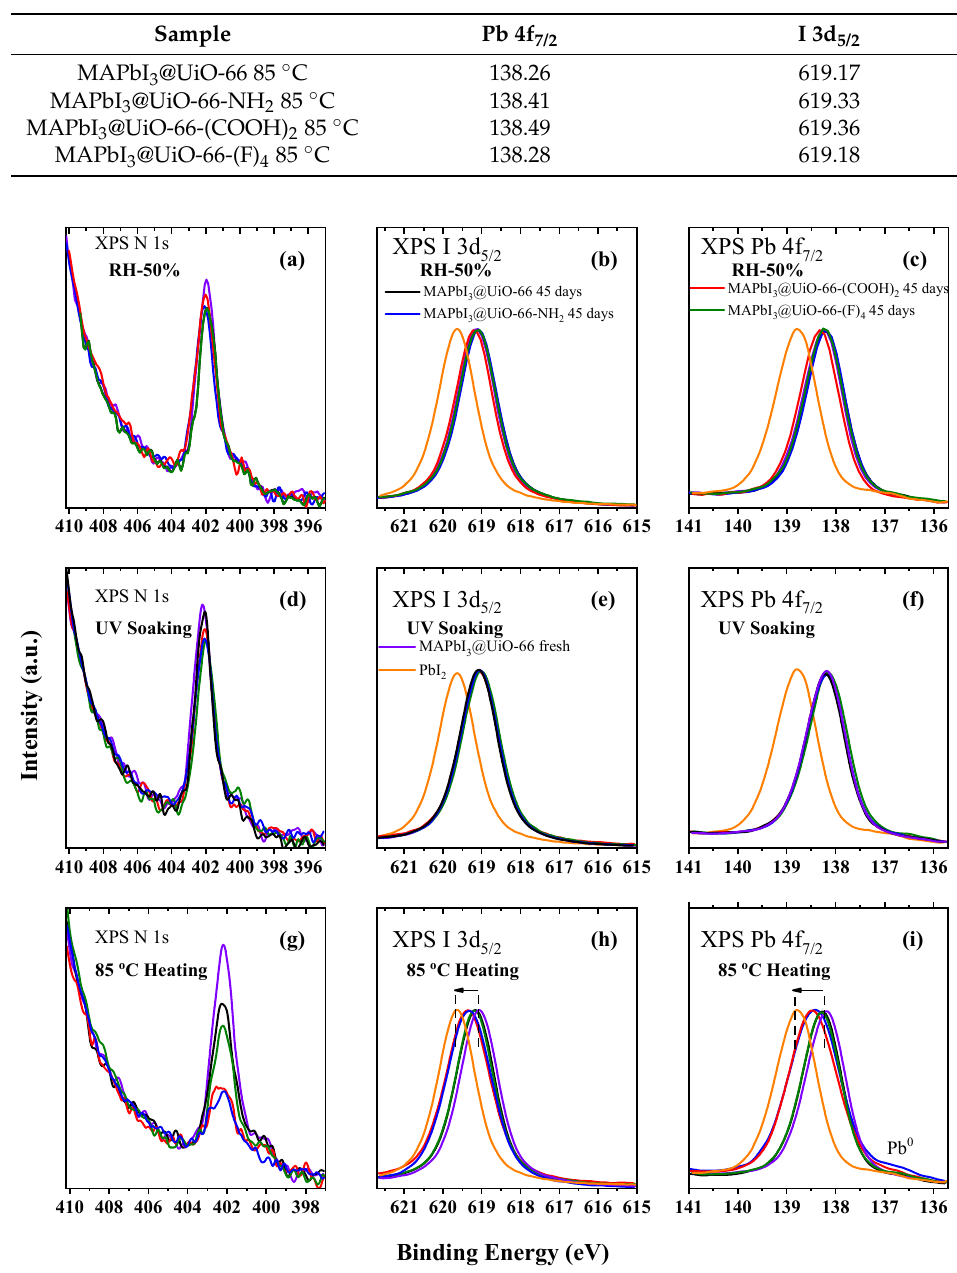
Figure 10. The XPS ( a , d , g ) N 1s, ( b , e , h ) I 3d, and ( c , f , i ) Pb 4f spectra of the MAPbI 3 @UiO-66 before and after ( a – c ) storage at RH 50%, ( d – f ) UV-light soaking, and ( g – i ) annealing at 85 °C for 45 days compared with the spectra of the PbI 2 reference sample.